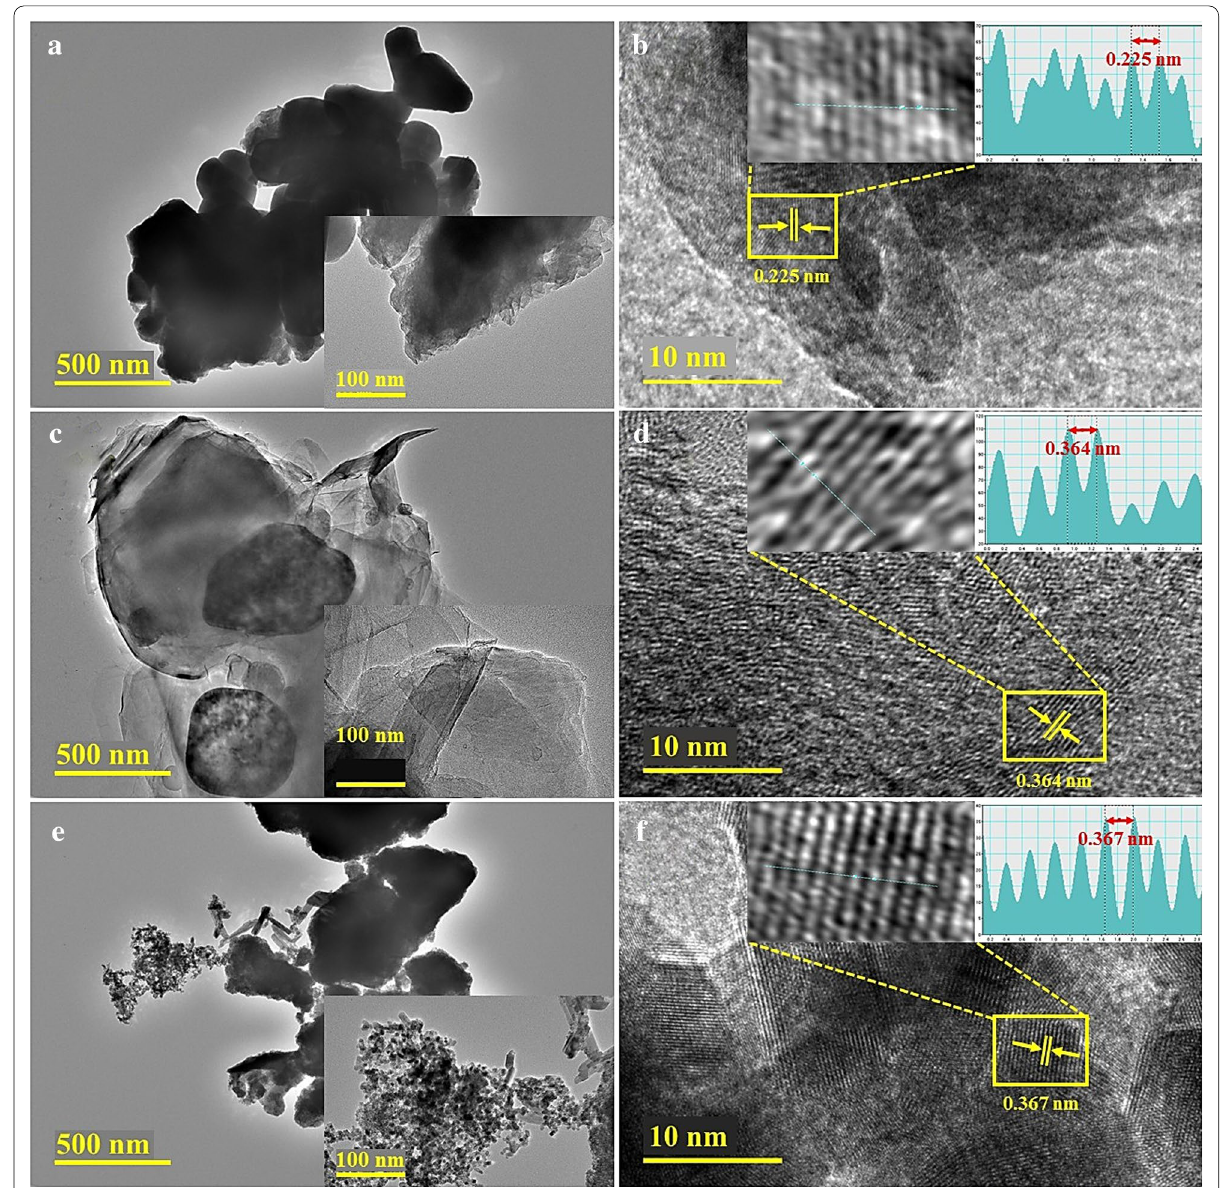
Fig. 6 a – c HR‑TEM and d – f lattice fringes of nanostructures obtained at annealing temperatures of 250, 500 and 750 °C,